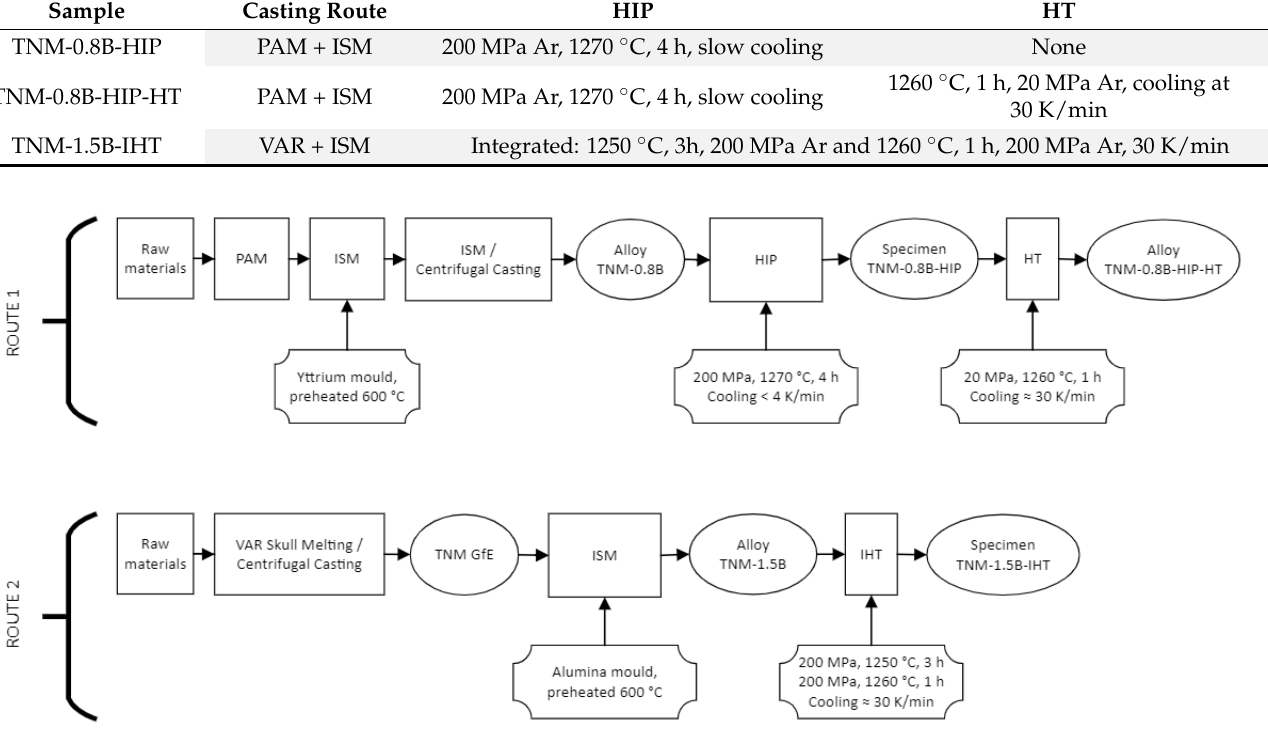
Figure 3. Flow chart of the manufacturing and processing routes.